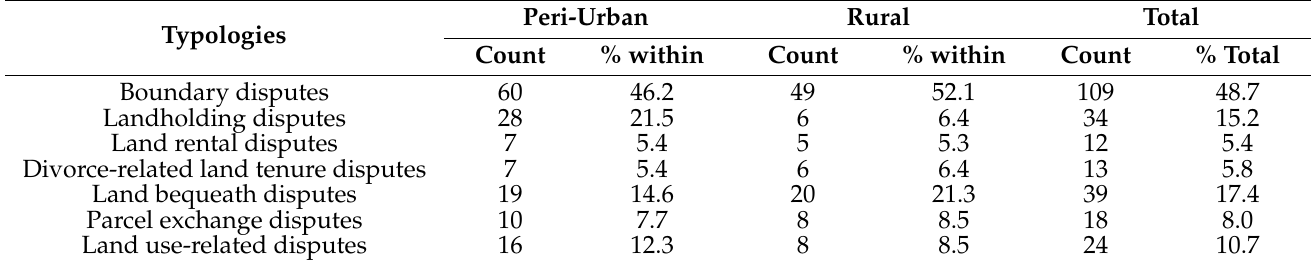
Table 3. Types of land tenure disputes (multiple responses).